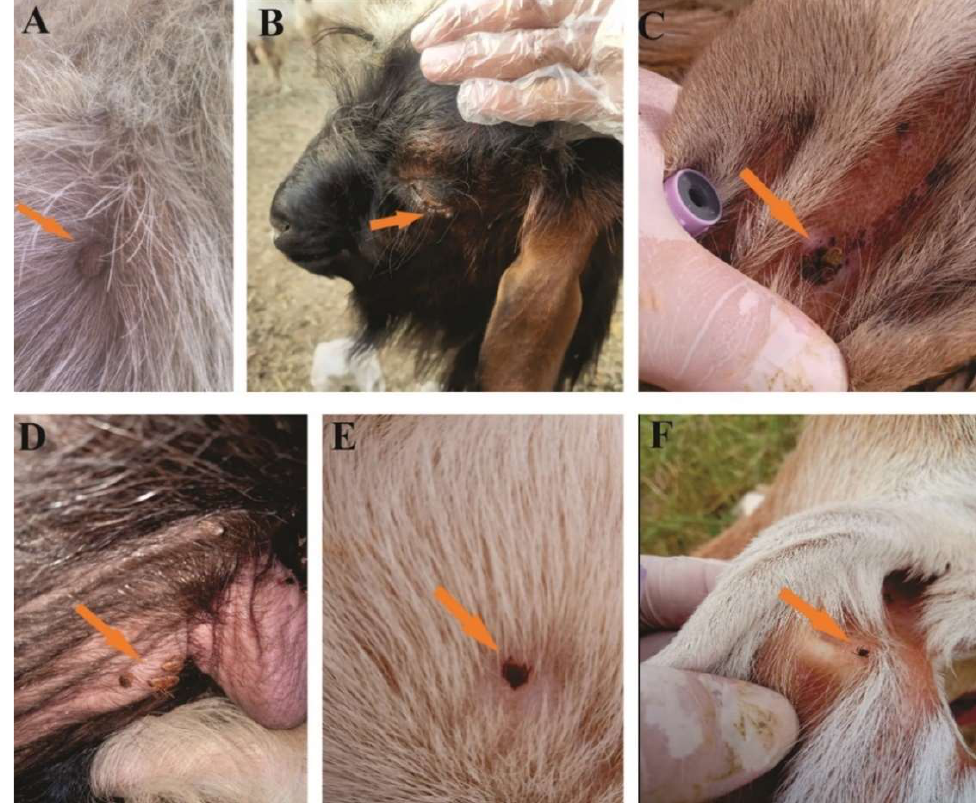
Figure 2. Tick infestation on different hosts: Hy. dromedarii from camels ( A ). Ha. bispinosa from goats ( B ). R. turanicus from sheep ( C ). Hy. anatolicum from male Asian water buffaloes ( D ). R. sanguineus from dogs ( E ). R. turanicus from goats ( F ).